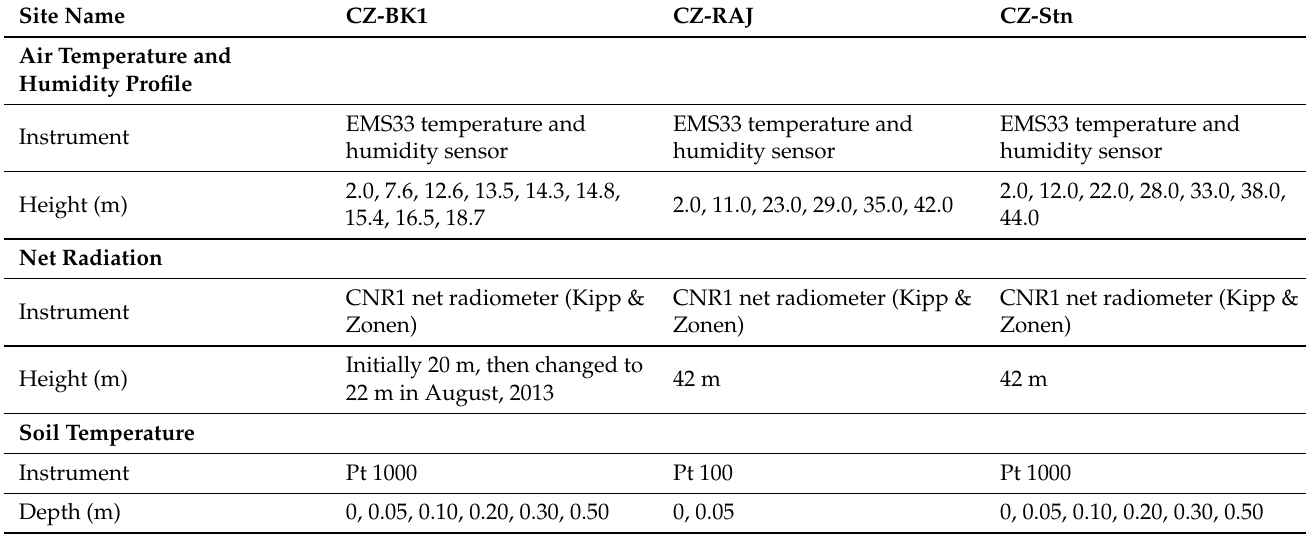
Table A2. Description of ancillary climatic measurements at the investigated